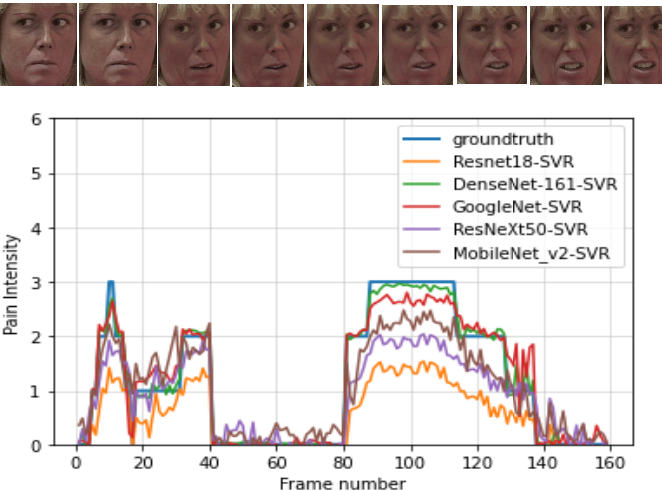
Figure 6. An example of continuous pain intensity estimation using all the considered CNN architec- tures on a sample video from the UNBC-McMaster